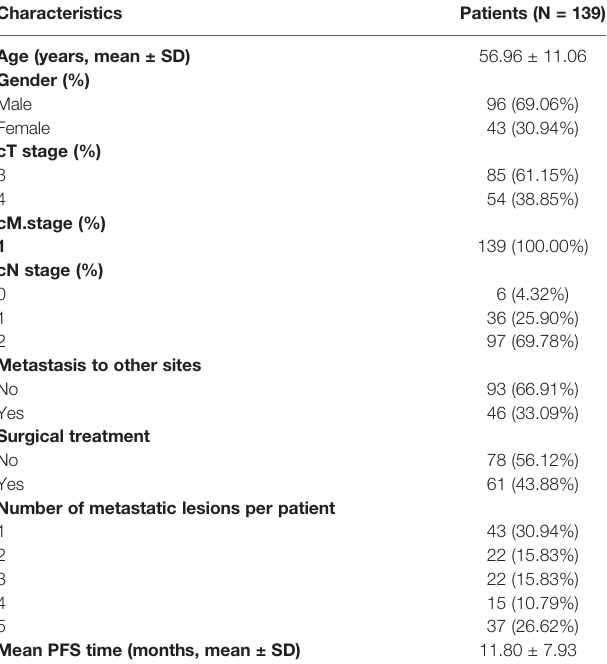
TABLE 1 | Clinical characteristics of patients.